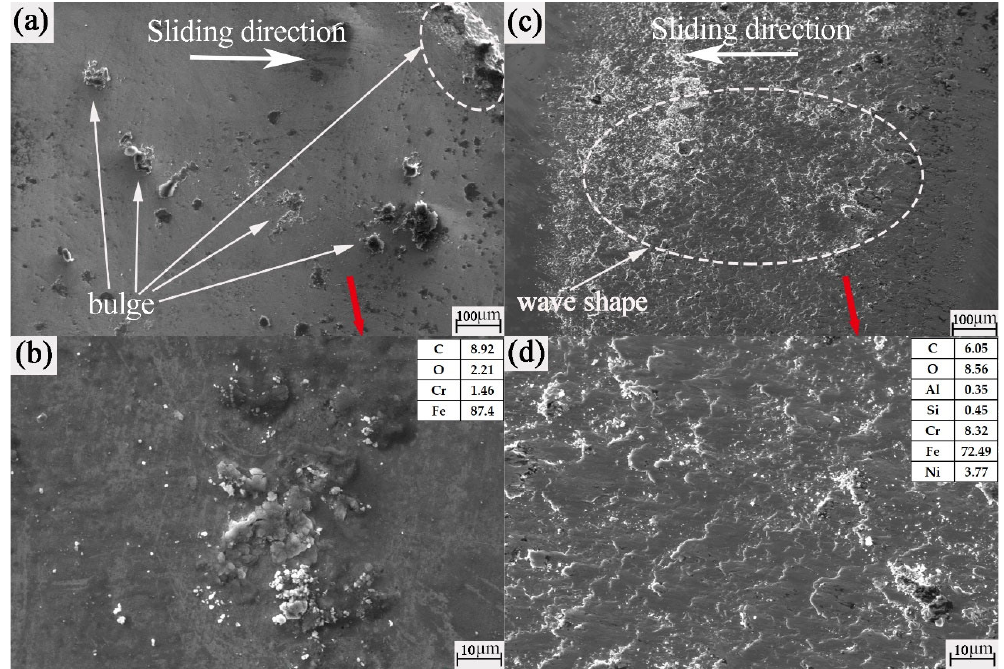
Figure 10. SEM images of the worn balls: ( a,b ) untextured rotation radius of 15 mm; ( c,d ) 0.8 mm groove width mechanical texture rotation radius of 15 mm.